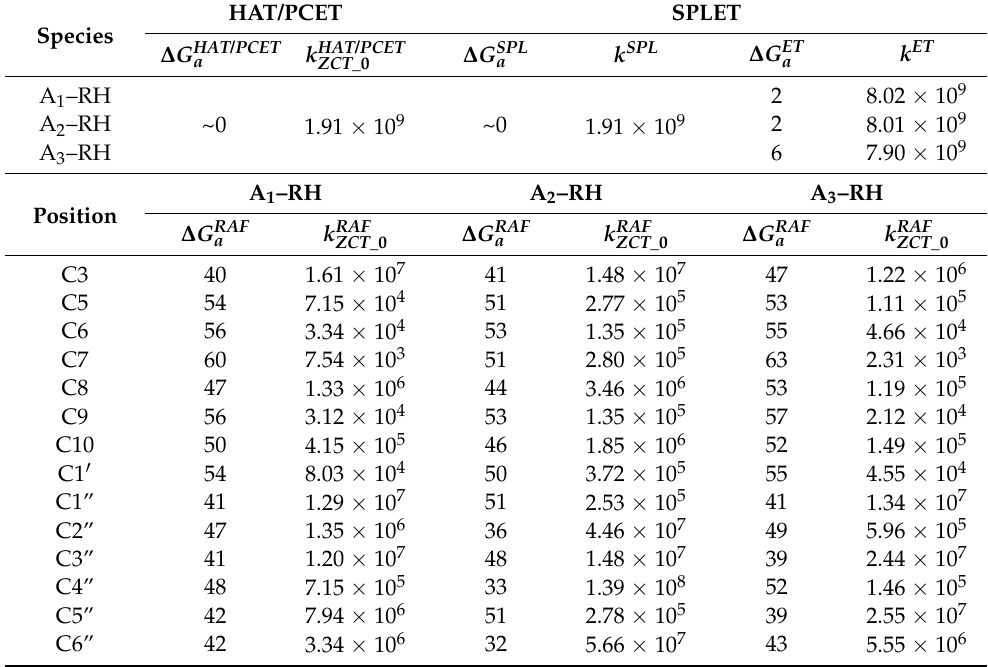
Table 2. Estimated values of kinetic parameters at 298.15 K: activation Gibbs energy ( ∆ G a , kJ · mol − 1 ) and rate constants of the bimolecular chemical reactions (M − 1 s − 1 ) between the investigated com- pounds A 1 –RH, A 2 –RH, and A 3 –RH and HO • estimated with the Eckart method (k ZCT_0 ). The k ET values (M − 1 s − 1 ) represent rate constants calculated with Marcus